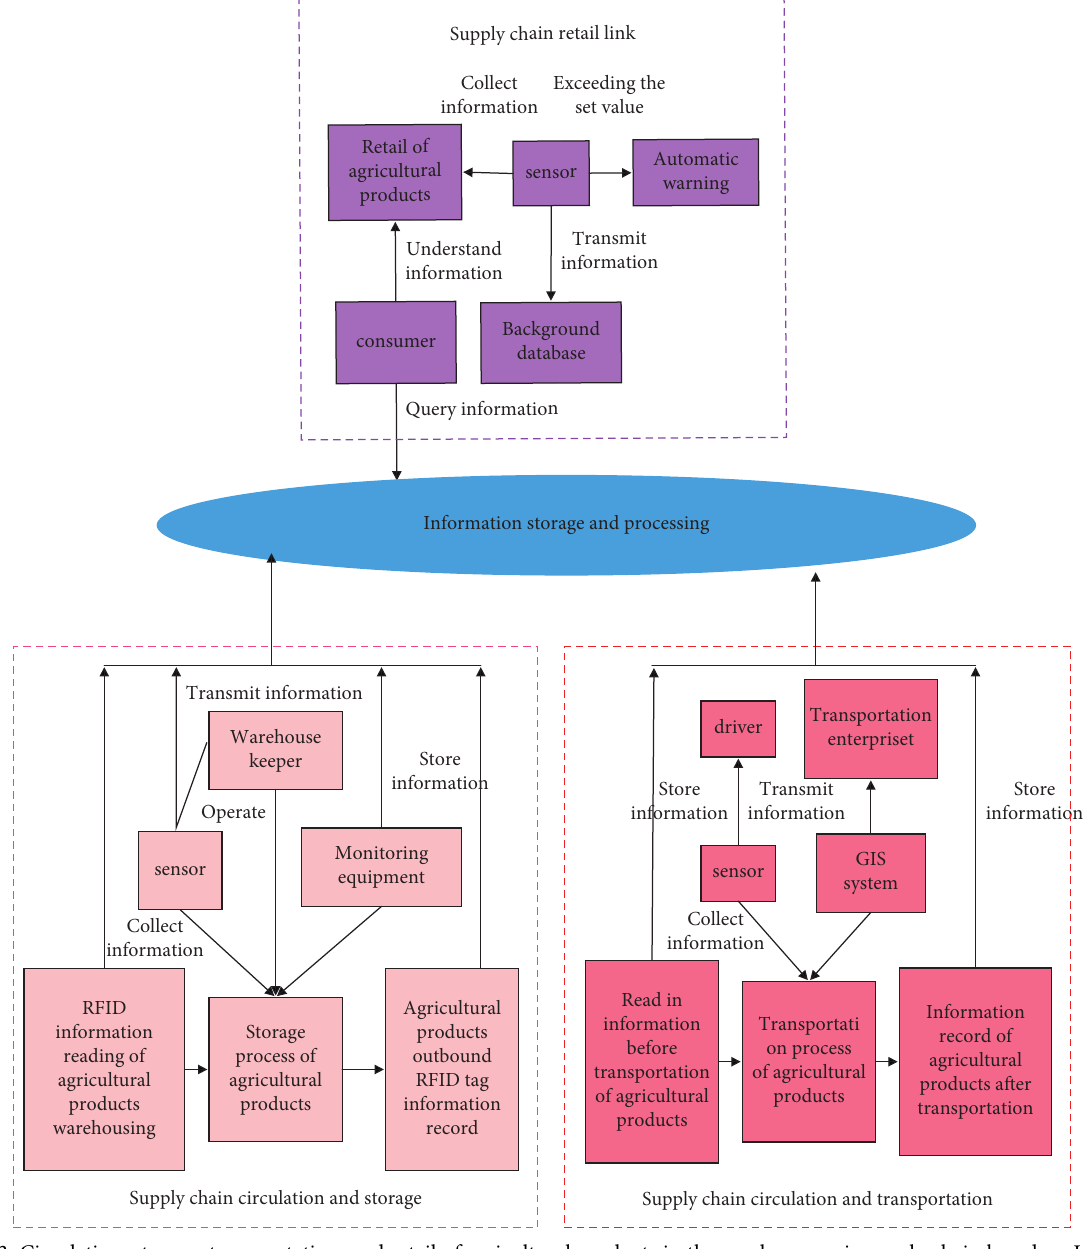
Figure 3: Circulation, storage, transportation, and retail of agricultural products in the rural economic supply chain based on Internet of Things